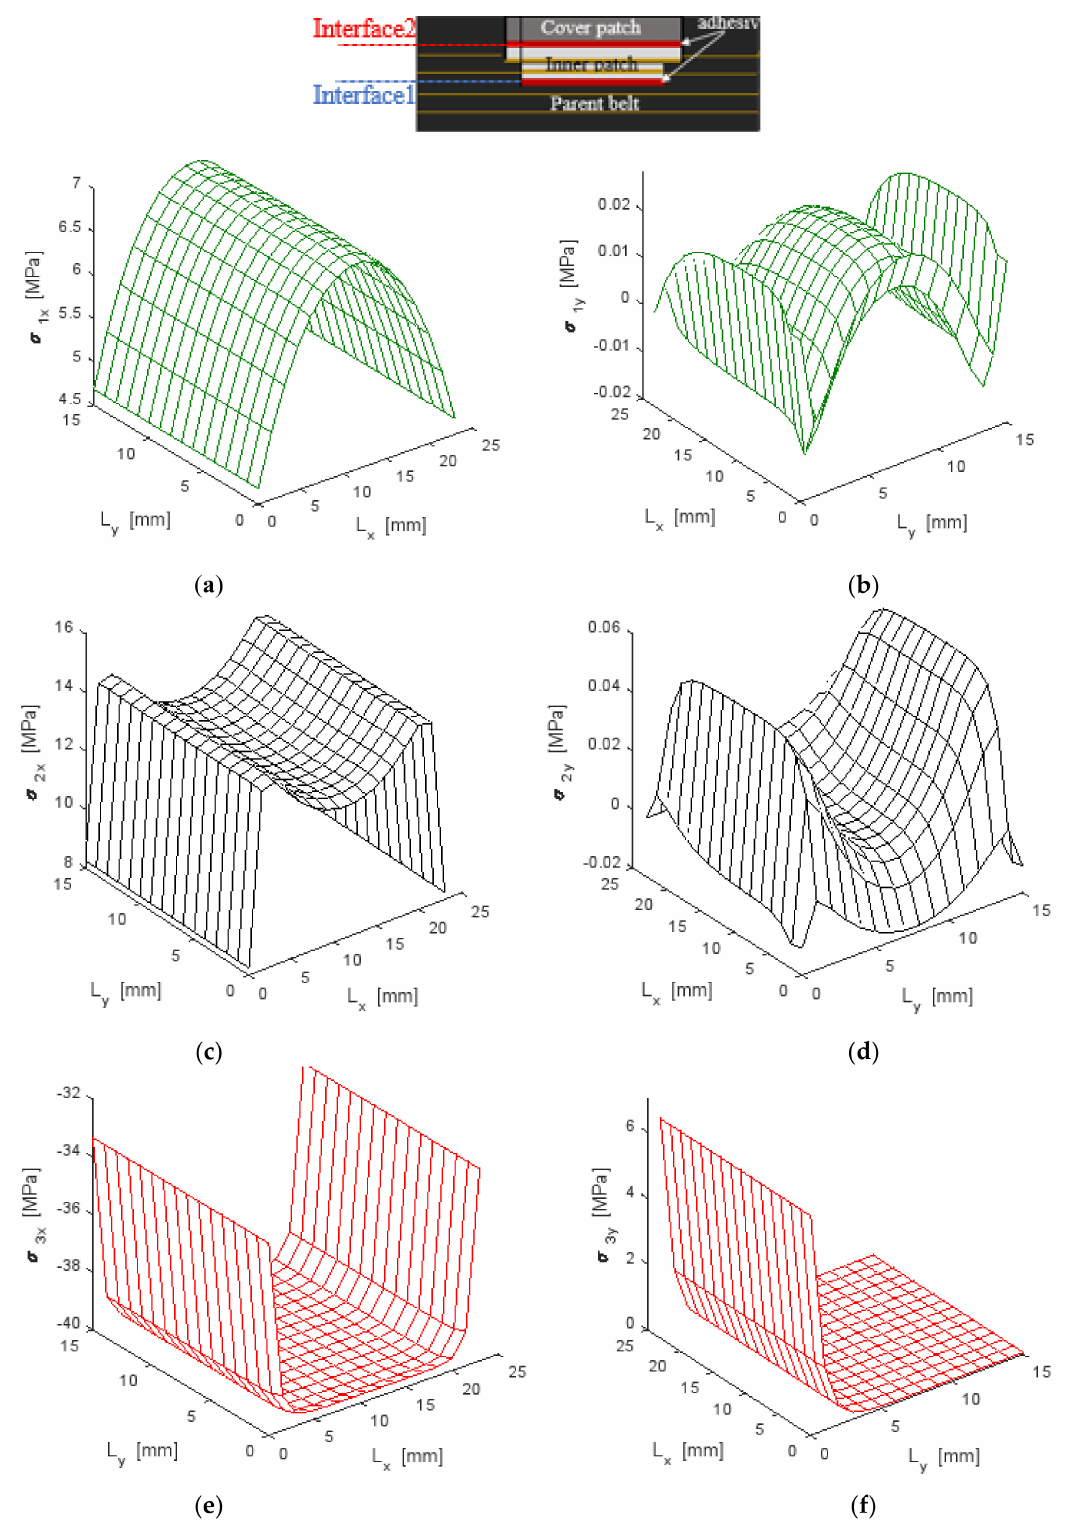
Figure 13. Normal stress distribution under a hygro-thermomechanical load (2 MPa, 50 ◦ C and 40% RH) in longitudinal and transverse directions in ( a , b ) a parent belt; ( c , d ) an inner patch; ( e , f ) a cover